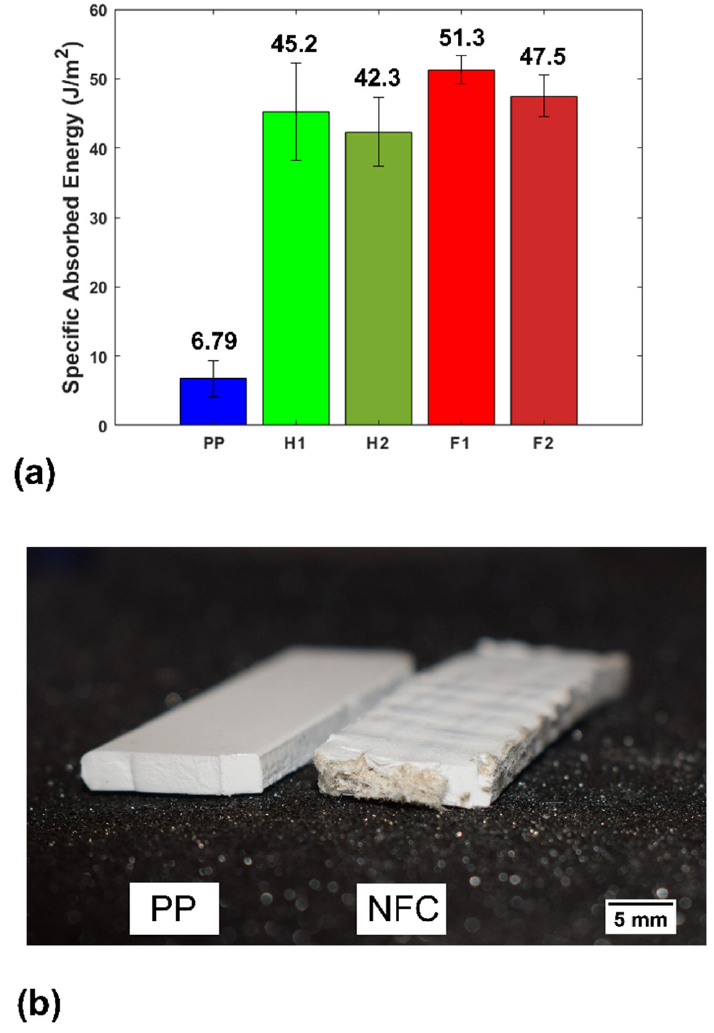
Figure 6. ( a ) Specific adsorbed energy for each sample type and ( b ) example of sample cross section at the end of the Izod tests.